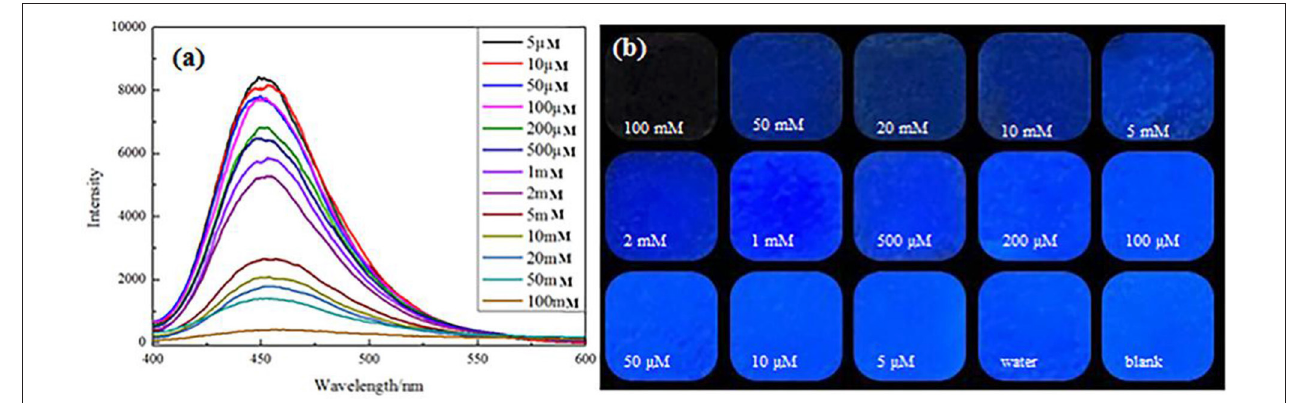
FIGURE 6 | Fluorescence spectra of the AMF in the presence of multifarious concentrations of Cr(VI) (a) . Pictures of the AMF with disparate concentrations of Cr(VI) exposed UV lamp (b) .